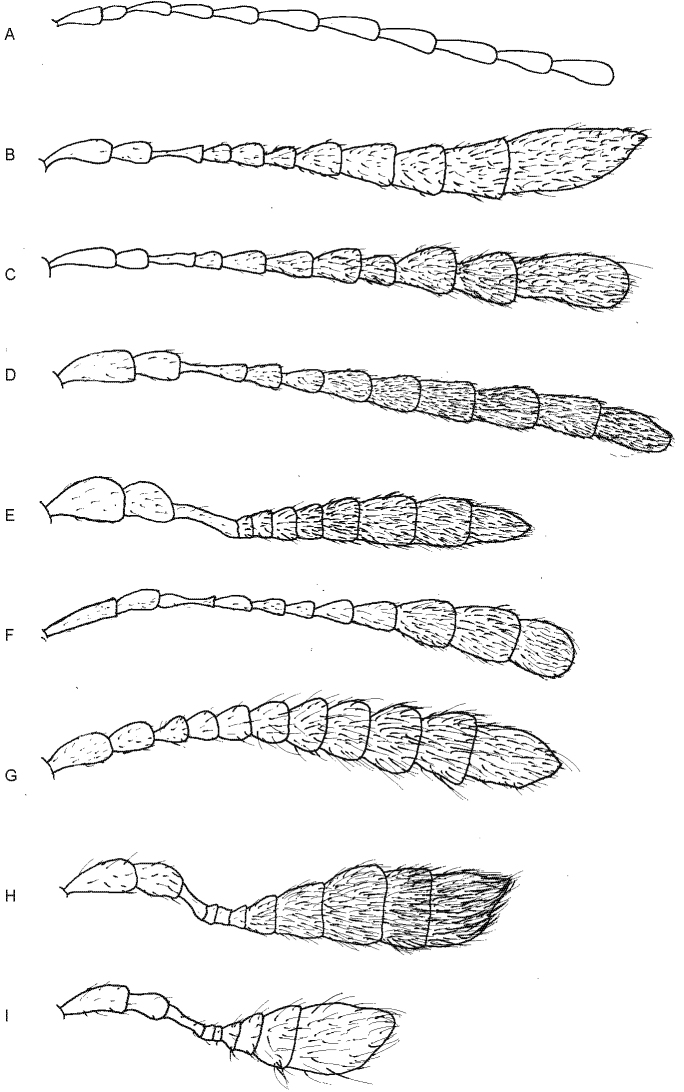
Antennae of various genera and species of moss-inhabiting flea beetles showing various level of antennal club formation AIvalia
besarBIvalia
lescheniCIvalia
iridescensDIvalia
uenoiEIvalia
antennataFMniophilosoma
laeveGBorinken
elyunqueHClavicornaltica
doeberliIKiskeya
baorucae.